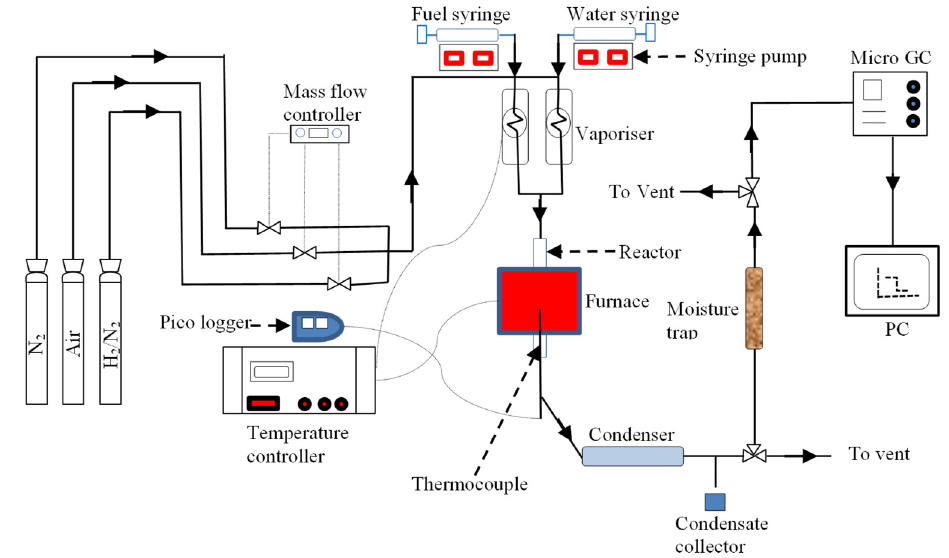
Figure 10. Schematic diagram of experimental rig.